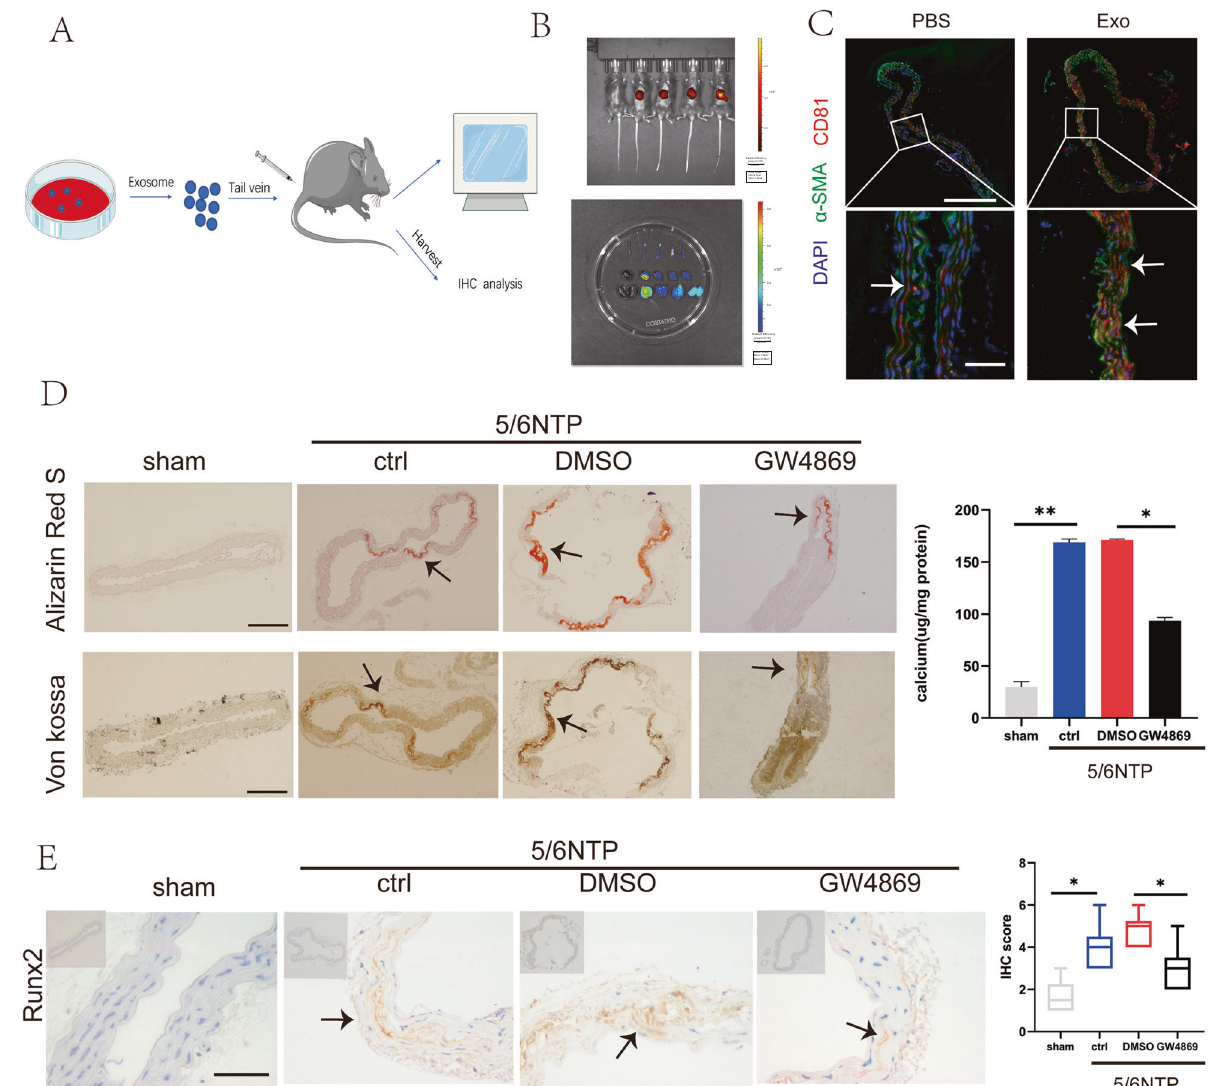
Fig. 5 ECs-Exos could be internalized by the artery and mediated arterial calci fi cation. A Schematic representation of procedure to trace ECs-Exos in mice. The ECs-Exos were labeled with the membrane-philic dye DIR and injected into mice through the tail vein. PBS was used as a negative control, and DIR dye was used as a positive control ( n = 5 per group). B After 24 h, fl uorescence signals were detected in the living mice (upper panel) and their organs after execution (lower panel). C The thoracic aorta was obtained to analyze the uptake of endothelial exosomes in the slices. Blue fl uorescence (DAPI)-labeled cell nuclei, green fl uorescence (Alexa 488)-labeled α -SMA, and red fl uorescence (Alexa 555)-labeled CD81 indicating exosomes(The upper scale bar = 200 μ m, the lower scale bar = 20 μ m). The white arrow indicates CD81 positive exosomes. D , E Evaluation of the effect of pre-treatment of the exosome blocker GW4869 on arterial calci fi cation induced by 5/6 nephrectomy. D Alizarin Red S (upper channel) and Von Kossa (lower channel) staining analysis of paraf fi n-embedded mouse vascular tissues. The arrows indicate mineralized nodules (scale bar = 200 μ m). E Immunochemistry analysis of osteogenic differentiation marker Runx2 expression. The arrows indicate the positive expression of Runx2 in the mouse artery (scale bar = 50 μ m). Data are represented as the mean ± SD, with fi ve replicates for each group. Two-way ANOVA analyzed signi fi cance with Turkey ’ s HSD post hoc analysis. * p < 0.05, ** p <